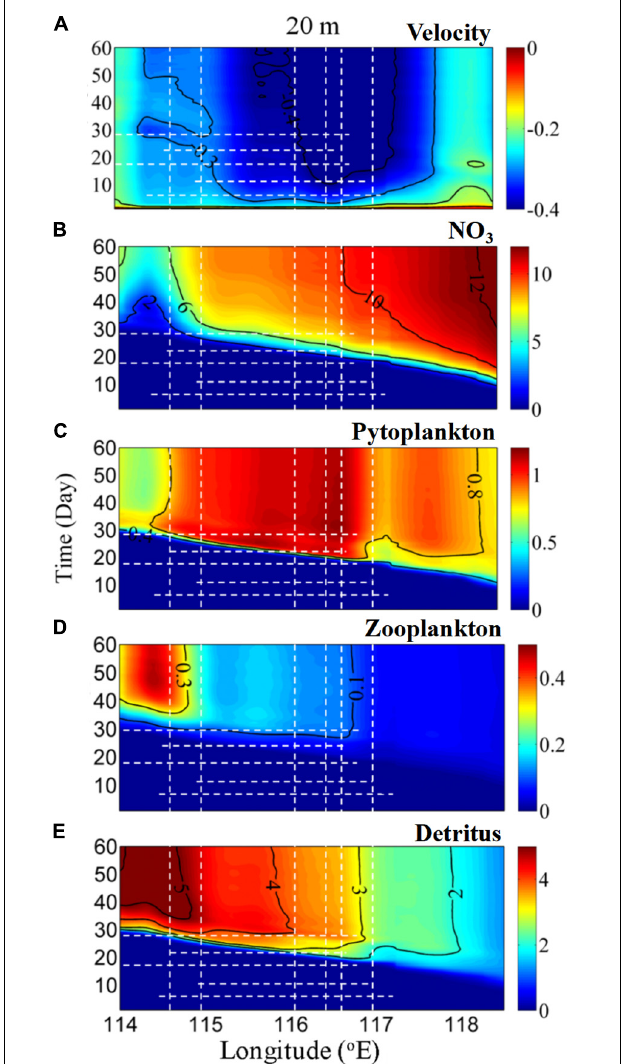
FIGURE 9 | Time series of the alongshore depth-integrated average (A) v (m s − 1 ; positive and negative values represent shoreward and seaward, respectively), (B) NO 3 ( N , µ mol L − 1 ), (C) P ( µ mol L − 1 ), (D) Z ( µ mol L − 1 ), and (E) D ( µ mol L − 1 ) as a function of the longitudinal distance along the 20 m isobath. The dashed white lines indicate the days of major events as mentioned in the main